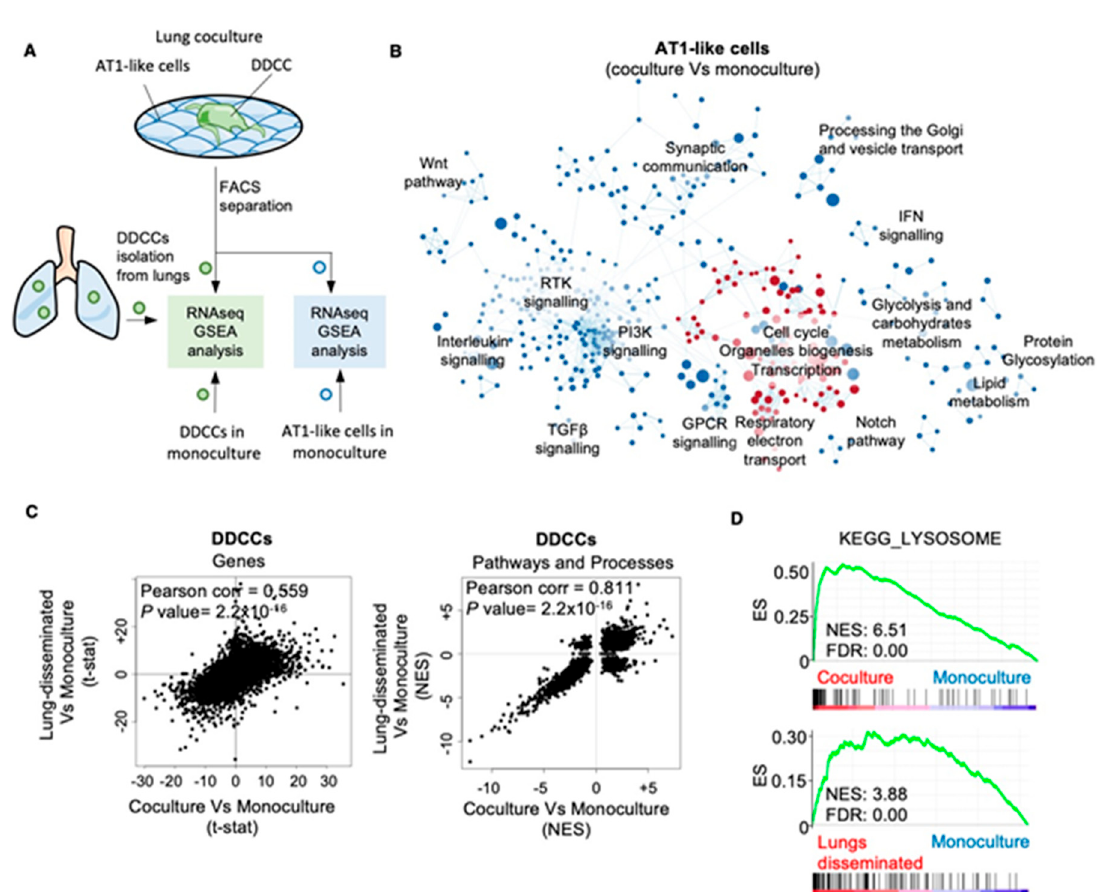
Figure 1. Comparison of the transcriptional programs activated in disseminated dormant cancer cells (DDCCs) from coculture, monoculture and lungs. ( A ) Outline of the transcriptomic analysis. ( B ) Enrichment map of lung AT1-like cells upon coculture with indolent breast cancer cells. The map shows gene-set enrichment results of AT1-like cells cocultured with D2.0R-EGFP cells compared with AT1-like cells in monoculture. Node size, genes in pathway; node color, enrichment score (red indicates enrichment in cocultured AT1-like cells, blue indicates enrichment monocultures of AT1-like cells); edge width, overlap size between connected nodes. ( C ) Scatterplots show the correlation between, left, the Wald’s statistic (gene level differences from DESeq2) and, right, the normalized enrichment score (pathway level differences from GSEA) of D2.0R-EGFP cells disseminated in vivo (lungs), in coculture or monoculture as indicated. ( D ) Profile of the running ES score for KEGG_LYSOSOME gene set after GSEA of D2.0R-EGFP cells disseminated in vivo, in coculture or monoculture as